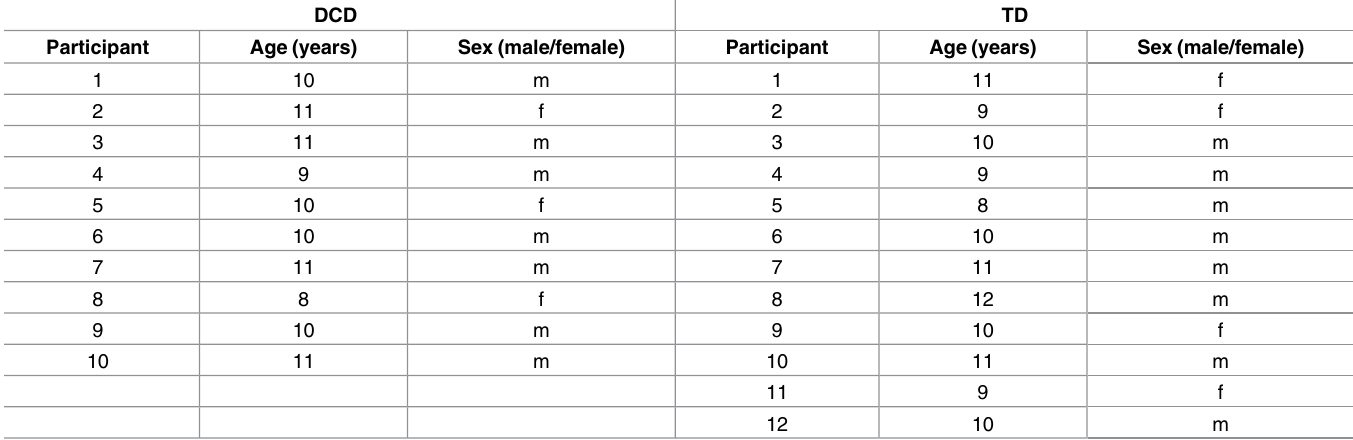
Table 1. Participant’s characteristics (age and sex) across the DCD and TD